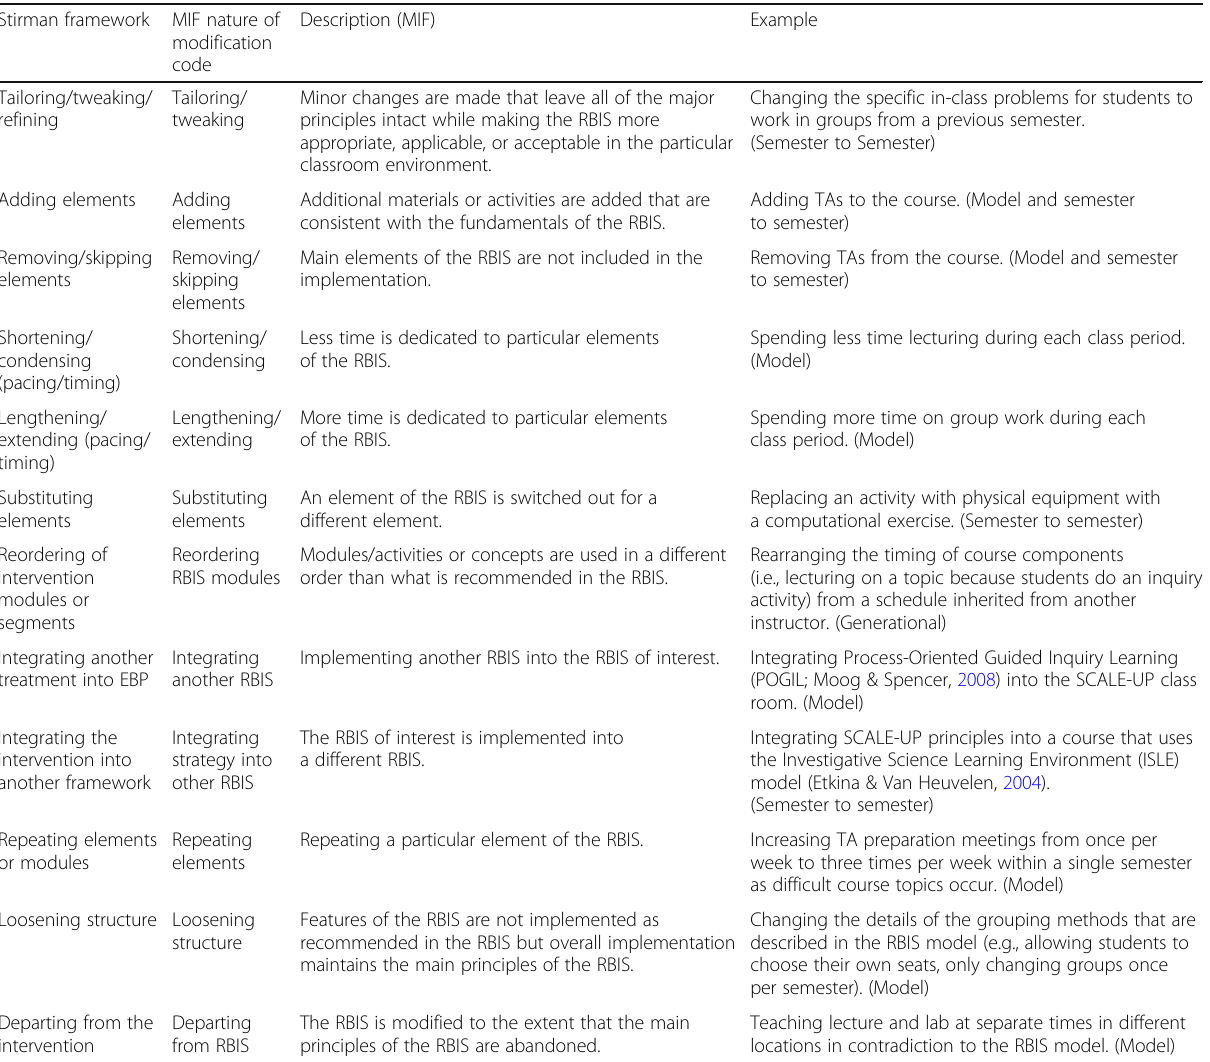
Table 4 Instructional practice change — nature of modification codes Stirman framework MIF nature of